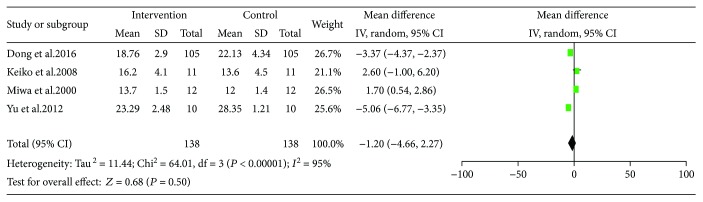
Forest plot for PRO%.